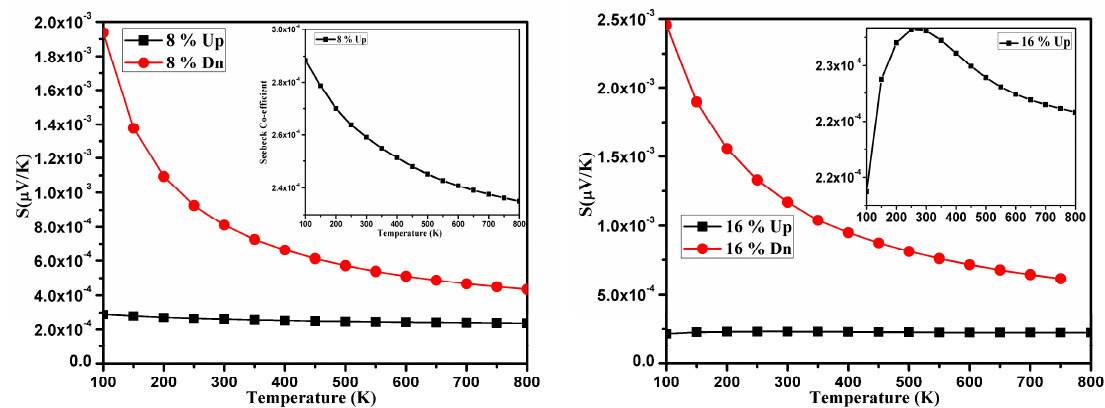
Figure 12. Temperature dependences of Seebeck coefficient (long solid curve ‐ black color for up) and (long solid curve ‐ red color for down) for Mn x Zn 1 − x Te (x = 8% and 16%).